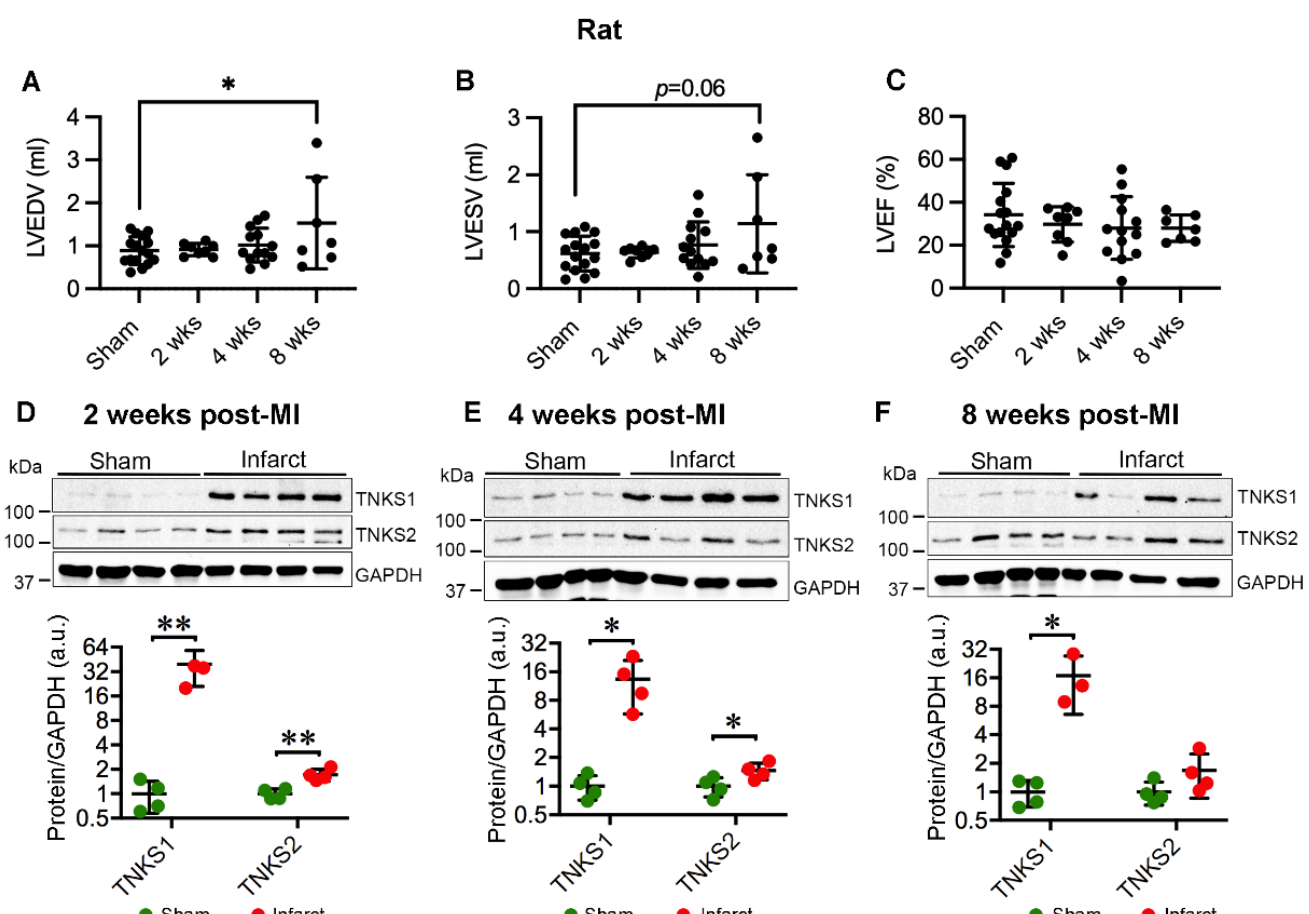
Figure 3. Ischemic injury boosts TNKS1 and TNKS2 in the infarct area in rat hearts. ( A , B ) Echocar- diography depicts increased left ventricular volume at 8 weeks post-MI compared to sham controls as determined by left ventricular end diastolic volume (LVEDV) ( A ) and left ventricular end systolic volume (LVESV) ( B ). ( C ) Left ventricular ejection fraction (LVEF). ( D – F ) Representative immunoblots of TNKS1 and TNKS2 in the infarct area in MI rat hearts and sham-operated controls at 2 ( D ), 4 ( E ), and 8 ( F ) weeks post-MI. The graphs represent quantifications of three replicate blots for the indicated proteins normalized to GAPDH. The results are presented as fold change compared to controls. The blurry band was excluded from the quantification. ( A – C ) Sham, n = 16; 2 weeks, n = 8; 4 weeks, n = 13; 8 weeks, n = 7. ( D ), Sham, n = 4; MI, n = 4. ( E ) Sham, n = 4; MI, n = 4. ( F ) Sham, n = 4; MI TNKS1, n = 3; TNKS2, n = 4. Data are presented as mean ± SD. One-way ANOVA with Tukey adjustment for multiple comparisons ( A – C ); two-sample t-test ( D – F ); * p < 0.05, ** p < 0.01.